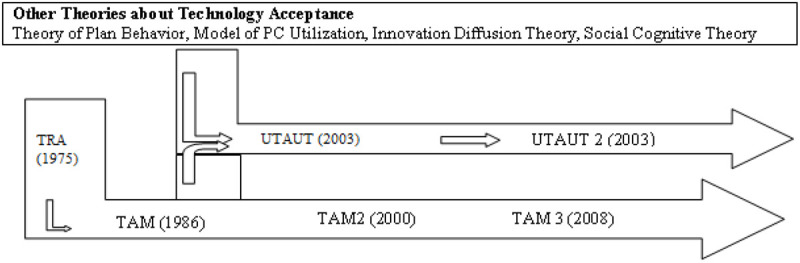
Evolution of TAM. Source: Im et al. (2011); Magsamen-Conrad et al. (2015), and Chauhan and Jaiswal (2016).